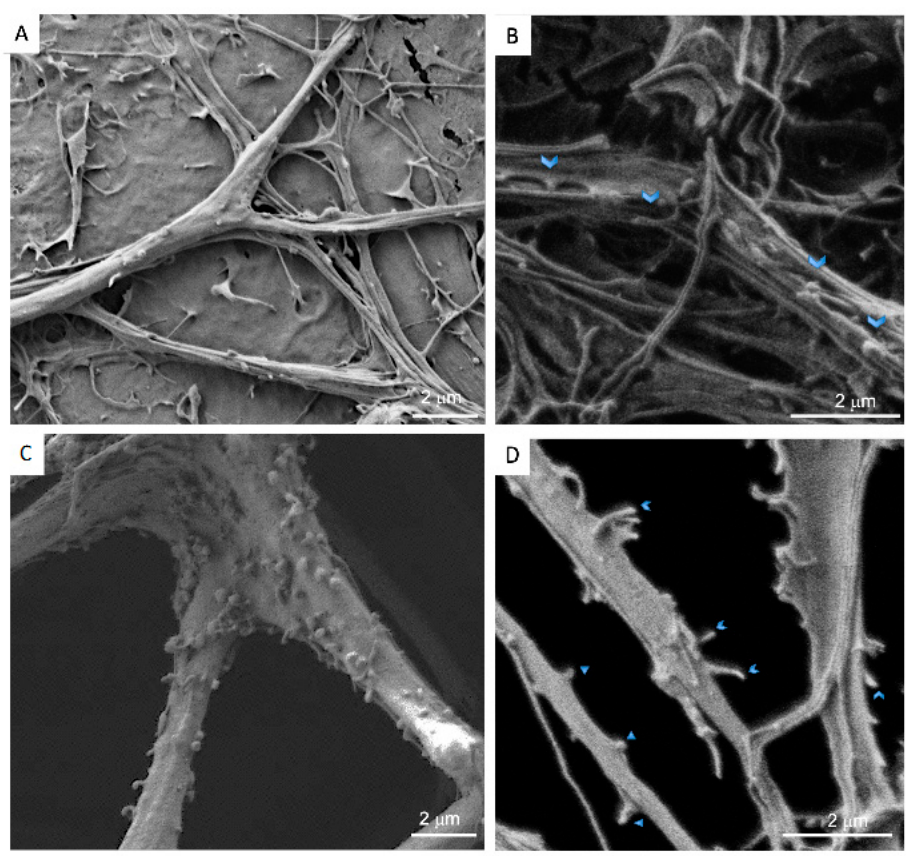
Figure 5. SEM microscopy of DIV21 hippocampal neurons co-cultured with astrocytes in 2D and in the 3D synthetic microscaffold Nichoid. ( A ) The 2D hippocampal astrocyte and neuron co-culture. Scale bar of 2 µ m. ( B ) Higher magnification of 2D hippocampal astrocyte and neuron co-culture. Filopodia and spines were indicated by arrows. ( C ) The 3D hippocampal astrocyte and neuron co-culture. Scale bar of 2 µ m. ( D ) Filopodia (arrow) and spine (triangle) numbers increased in 3D hippocampal astrocyte and neuron co-cultures. Scale bar of 2 μ m.